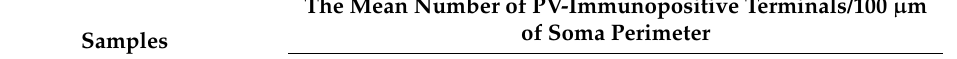
Table 3. The mean number of PV-immunopositive terminals/100 µ m of soma perimeter in the two cases with giant cells compared to matched